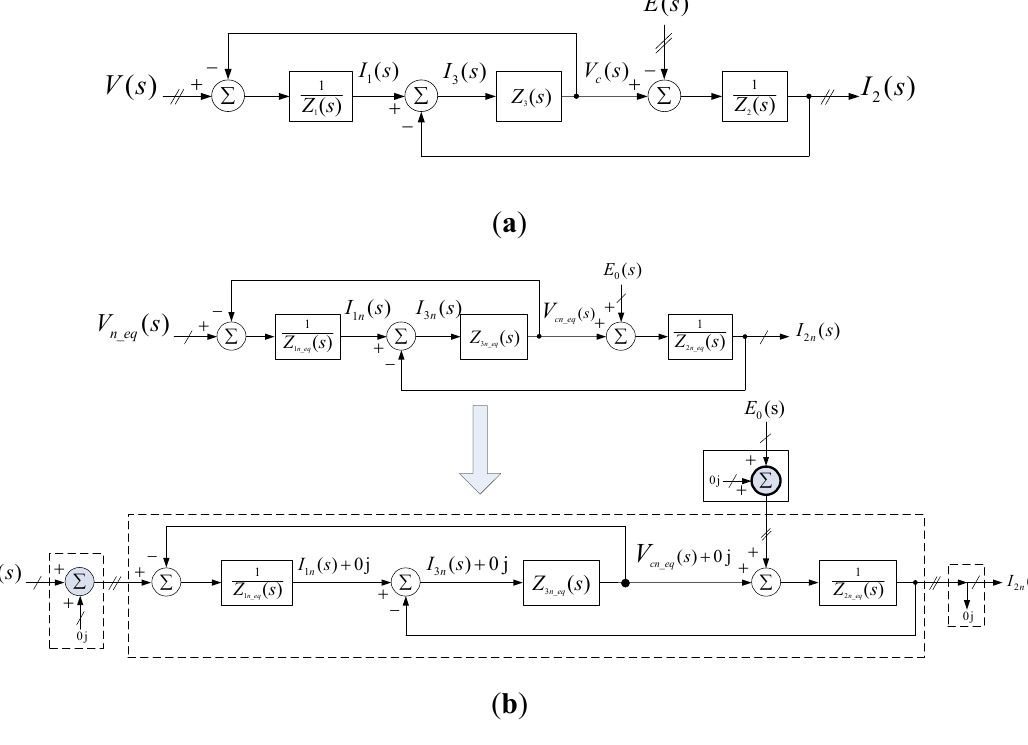
Figure 6. 4B- LCL model in the ( a ) non-zero-sequence and ( b )